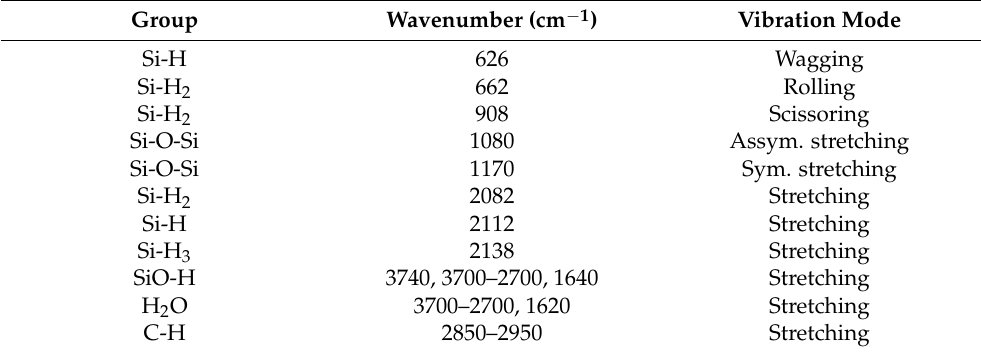
Table 1. List of the key chemical surface groups with the corresponding wavenumbers of their IR-absorption bands